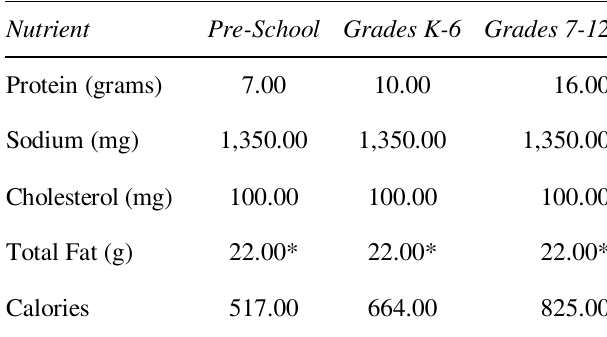
Table 1: Nutrient recommendation for school children